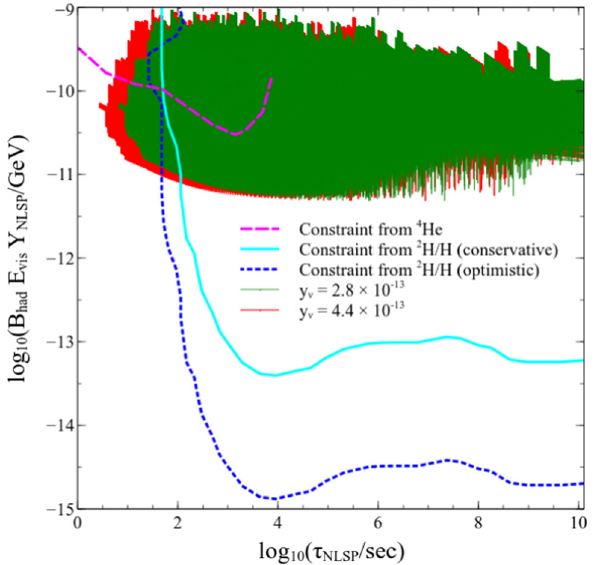
Fig. 11 Allowed parameter region in the lifetime-injected hadronic energy plane which satisfies every existing constraint for the ‘hierar- chical’ (green) and degenerate (red) neutrino masses. The two curves are for the constraint from 4 He (magenta dashed) and 2 H/H (cyan solid) abundance. The dotted (blue) curve denotes the impact of assuming a tightened 2 H/H determination